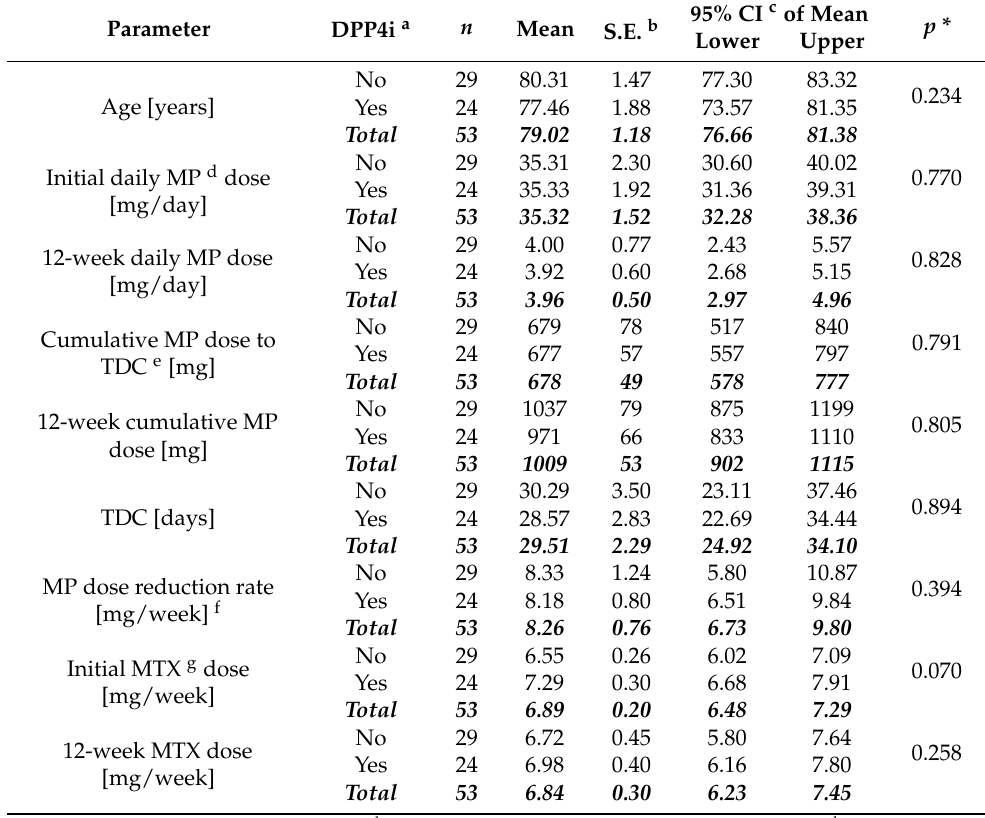
Table 1. Core demographic and treatment parameters of the cohort ( n = 53, Total ). In addition, a comparison of patients taking dipeptidyl peptidase 4 inhibitor ( n = 24) or not ( n = 29) at the time of bullous pemphigoid diagnosis.